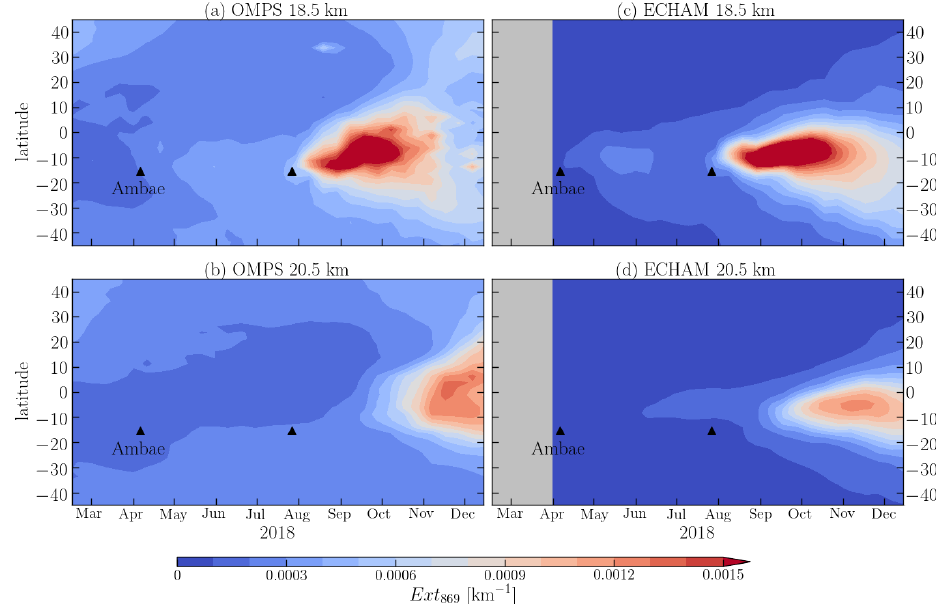
Figure 4. The evolution of the aerosol extinction coefficient ( Ext 869 ) at 18.5 and 20.5km altitude after the Ambae eruptions of 2018. In panels (a) and (b) , Ext 869 was retrieved from OMPS-LP measurements; for panels (c) and (d) , Ext 869 was modeled by MAECHAM5-HAM. Both data sets were averaged over 10d